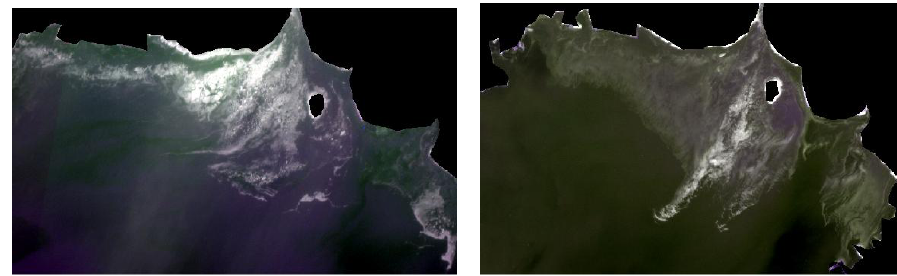
Figure 3: Land and island mask